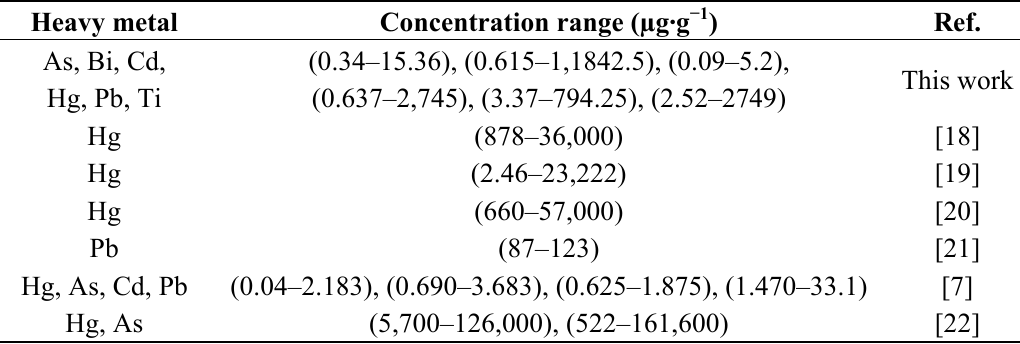
Table 9. Compare the results of the study with previous